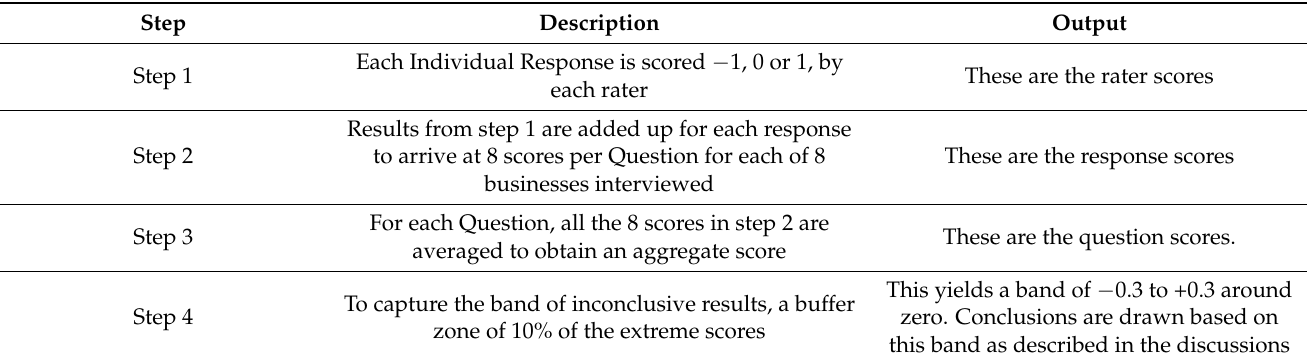
Table 2. Steps and Levels of